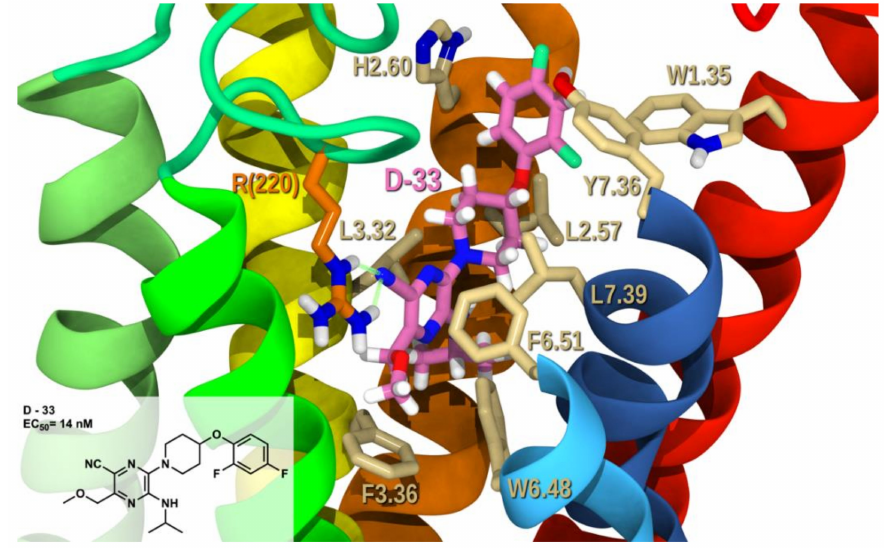
Figure 10. D-33 / GPR6 R complex. The view from the lipid bilayer with the EC portions of TMH6-7 removed for